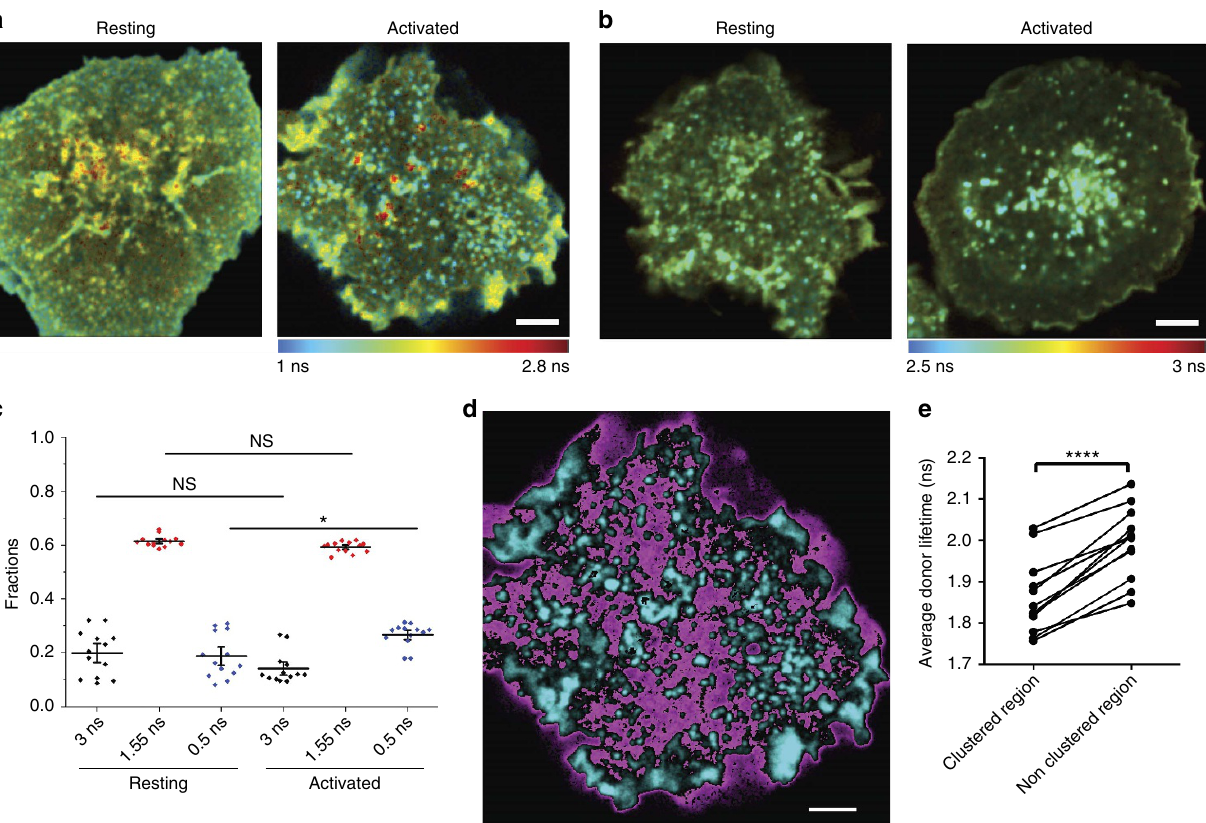
Figure 4 | FLIM imaging of CD3 f -CliF clustering in Tcells. ( a , b ) Donor lifetime image of Jurkat cells expressing CD3 z -CliF ( a ) or CD3 z -Venus ( b ) under resting (glass surface coated with anti-CD90 antibodies) and activating (glass surface coated with a mixture of anti-CD3 and anti-CD28 antibodies) conditions. The lifetime is pseudocoloured blue to red as indicated by the colour scale. Scale bar, 2 m m. ( c ) Lifetime fractions derived from triple exponential decay fits in resting and activated T cells. Horizontal bars indicate means and error bars are s.e.m. Data are from n ¼ 13 cells per condition. ( d , e ) Comparison of average donor lifetime of high-intensity regions (cyan, based on pixel intensity) and low-intensity regions (magenta) ( d ) of the activated cell shown in a and corresponding values ( e ). In e , each symbol is one cell, P o 0.01, n ¼ 9 cells (paired t -test). More than 200 photons/pixel were recorded for all FLIM